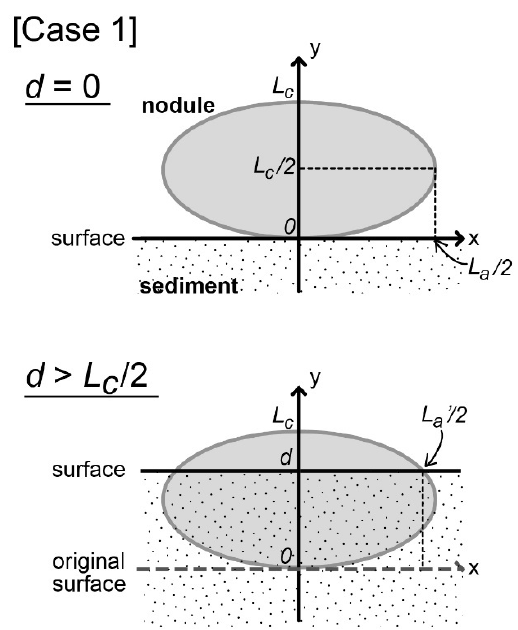
Figure 2. Schematic illustration of a cross section of a nodule and sediment that shows positional relations for Case 1. The hypothetical nodule has long axis of L a and thickness of L c . The bottom of the nodule comes into contact with the sediment under the initial condition ( d = 0). When d > L c /2, the nodule’s apparent size is smaller, as shown in the bottom part of the figure.